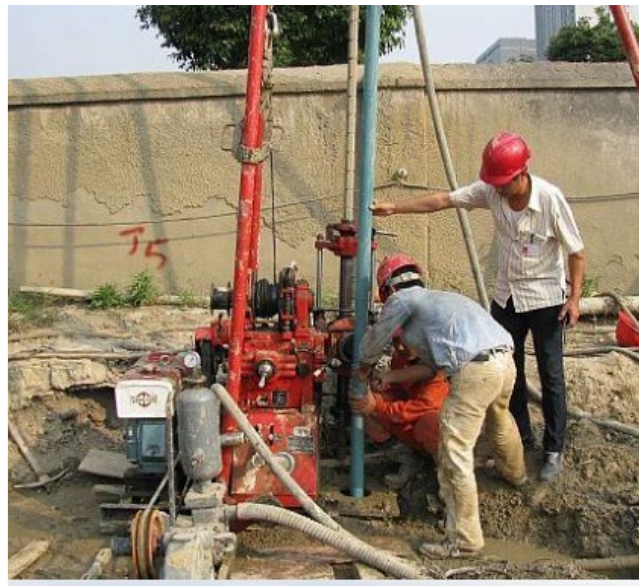
Figure 6. Borehole downpipe-buried.